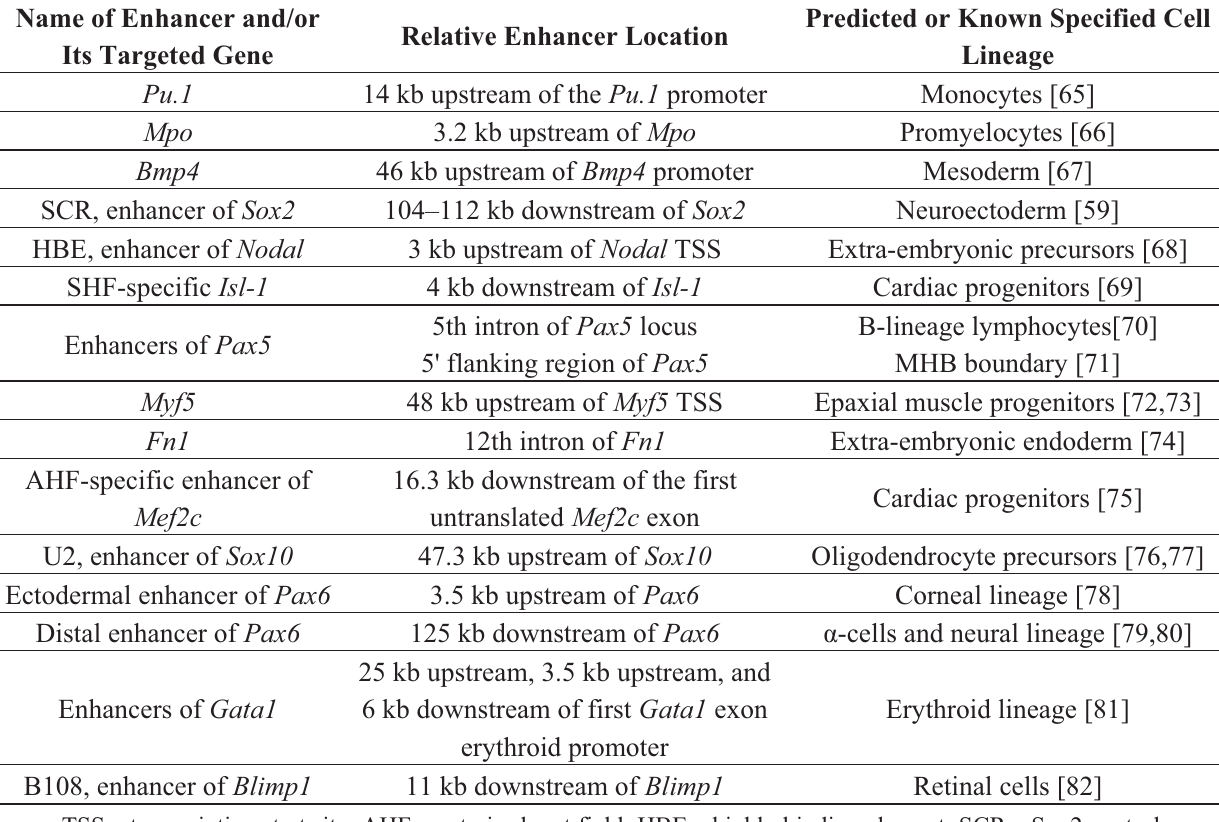
Table 1. Enhancers and their predicted or known role in lineage